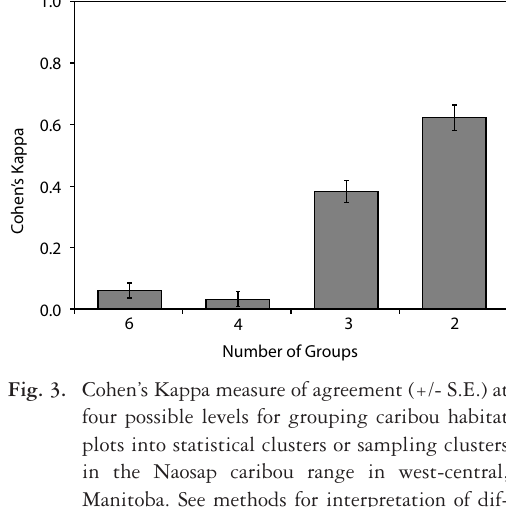
Fig. 3. Cohen’s Kappa measure of agreement (+/- S.E.) at four possible levels for grouping caribou habitat plots into statistical clusters or sampling clusters in the Naosap caribou range in west-central, Manitoba. See methods for interpretation of dif- ferent group memberships.